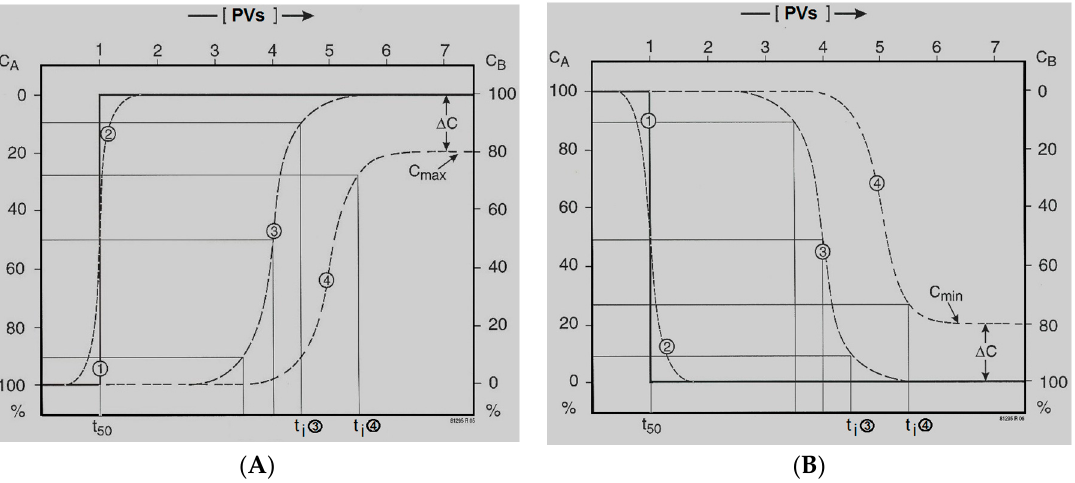
Figure 4. Characterization of the breakthrough of a compound dissolved in fluid B (concentration C B ), which displaces fluid A (concentration C A ), in terms of travel time ( t 50 ) and 90% break-through or leach times ( t i ; t i 3, t i 4 = ti for curve 3 and 4, respectively), the dimensionless parameter PV (pore volumes flushed) and the (semi)permanent concentration change ( Δ C), the maximum concentration (C max ) or minimum concentration (C min ) after full break-through or leaching. Line 1 = conservative tracer (R = L = 1) without dispersion; Curve 2 = as 1, however, with dispersion; Curve 3 = compound retarded by sorption or leaching (R = L = 4); Curve 4 = compound retarded by ad- or desorption (R = L = 5), with continued removal c.q. addition. ( A ) (C B > C A ); and ( B ) (C B < C A ).